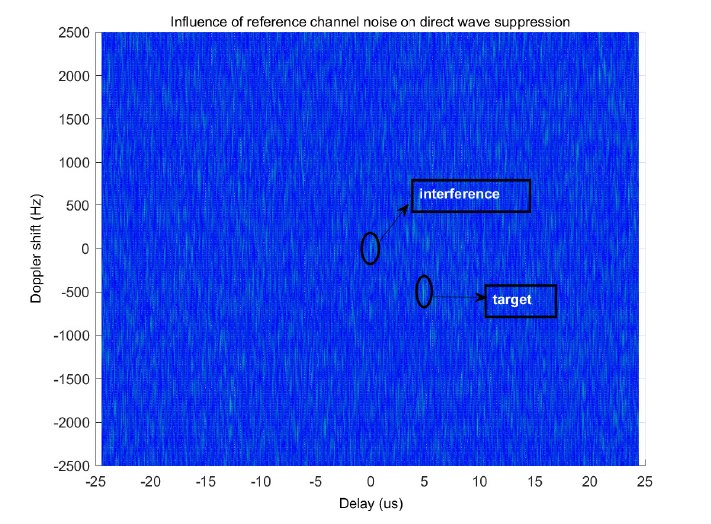
Figure 5. The influence of reference channel SNR on interference suppression process with SNR = 5